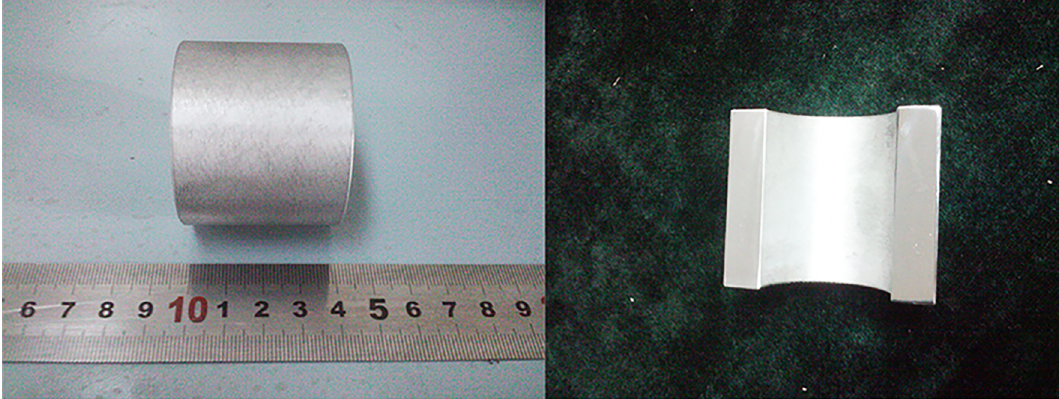
Figure 2. Cross-section of the squeezed pipe.